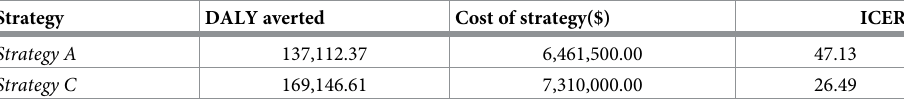
Table 12. Comparison between ICER of strategies A and C in terms of DALY.